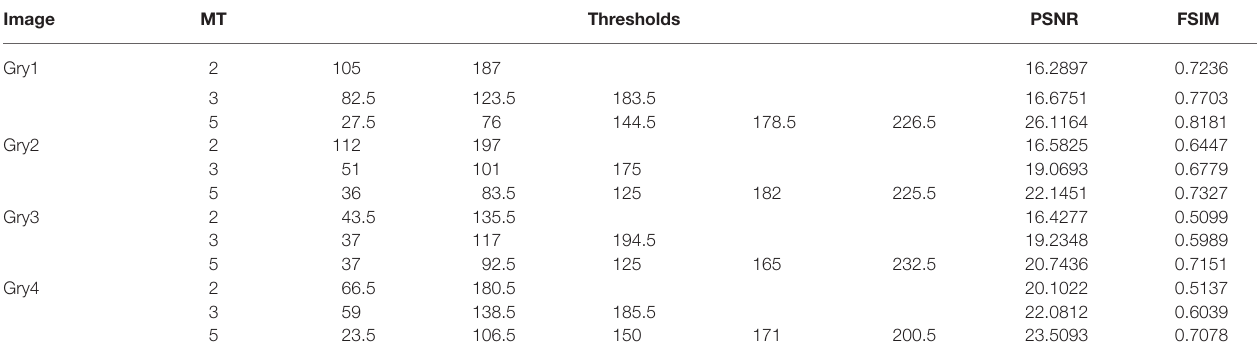
TABLE 8 | Experimental data of the plant image